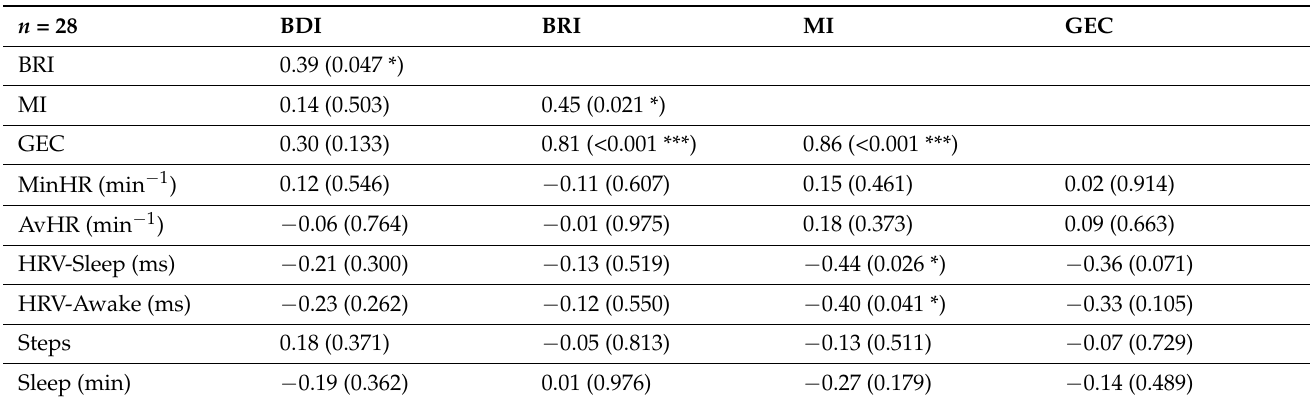
Table 5. Spearman ´ s partial rank correlation coefficients and statistical significances for BDI score, BRIEF-A indices, and Firstbeat ® results with gender and BBI-15 score controlled for ( p < 0.05 (*), p < 0.001 (***)).